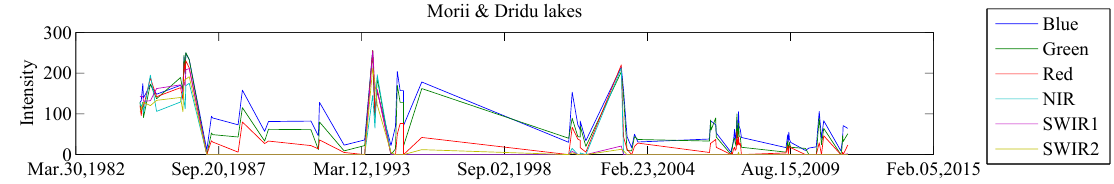
Figure 1. Spectro-temporal signature in a Landsat satellite image time series